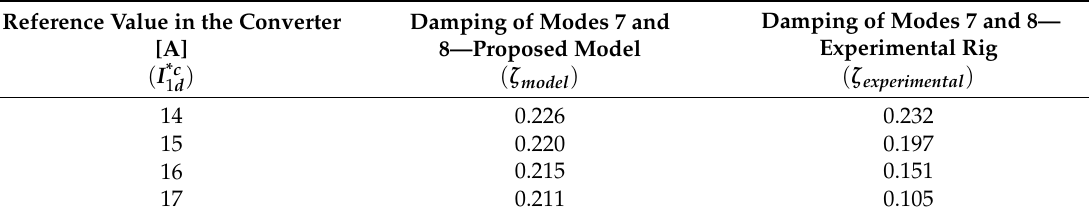
Table 8. Comparison between the damping of modes 7 and 8 given by the proposed model and the those found in the experimental system, for SCR = 1.6265 and PLL bandwidth equal to 30.898 Hz. Reference Value in the Converter